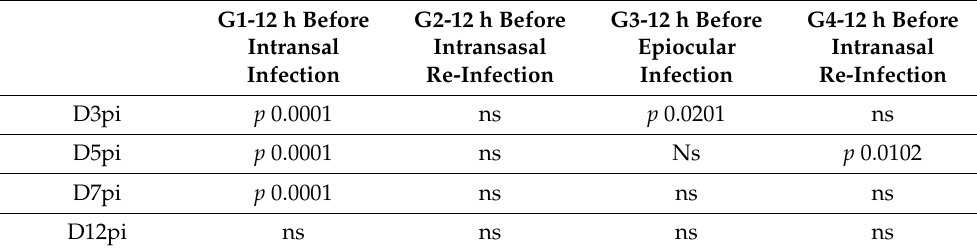
Figure 3. Whole body plethysmographic data as dimensionless value of Penh of all hamster groups during the experiment from 12 h before infection (bi) up to 14 days post infection (dpi) with SARS-CoV-2 virus. Table 1. Statistical analysis ( t -test) comparing the Penh (Figure 3) of the control animals n = 24 before exposure and in the different groups after infection significant differences to the control before infection (n = 24) animals. P: level of significance and ns: not